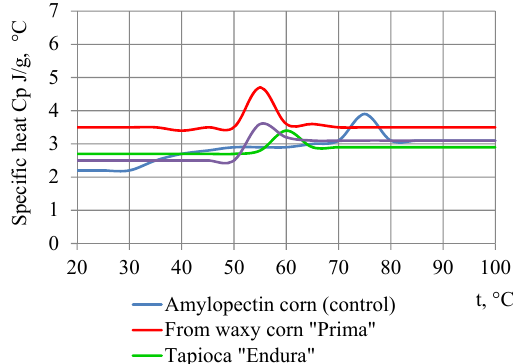
Fig. 1 . DSC curves for starch